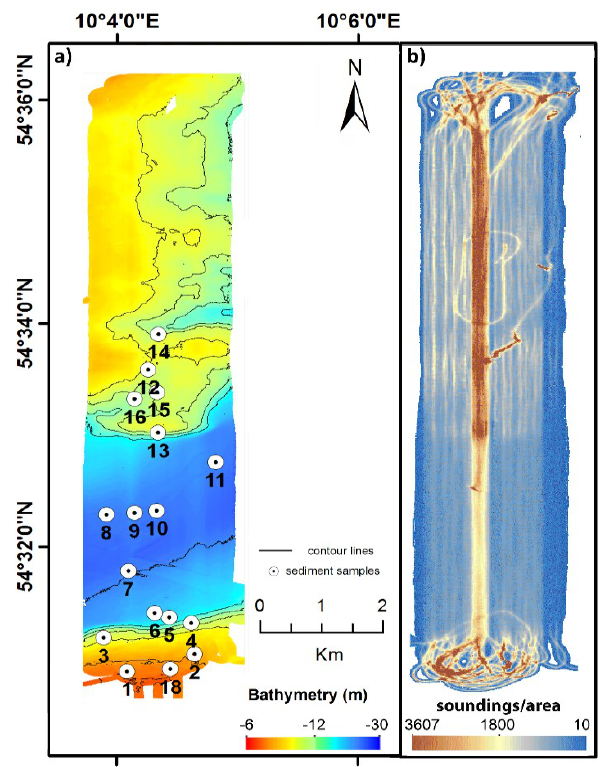
Figure 2. ( a ) Bathymetry of the study area with locations of sediment samples. ( b ) Sounding density map within an equivalent area of 5 × 5 m 2 .